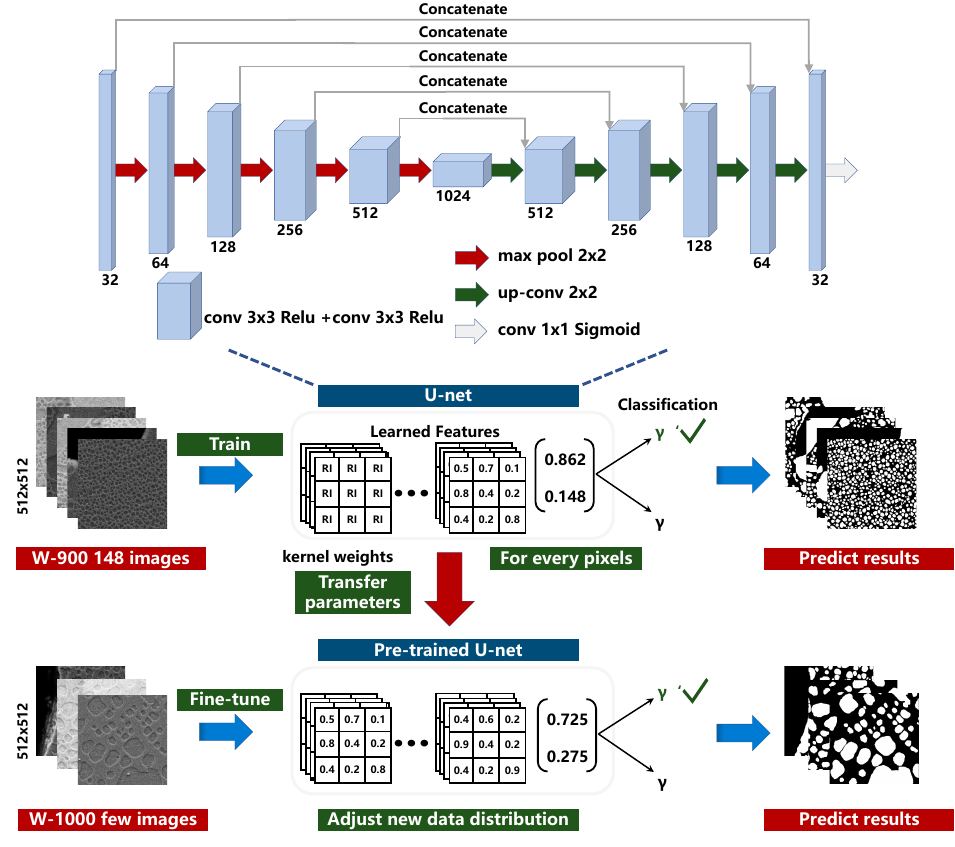
Figure 2. The schematic flowchart of deep transfer learning method from W-900 to W-1000, wherein the U-Net architecture is employed as the basic